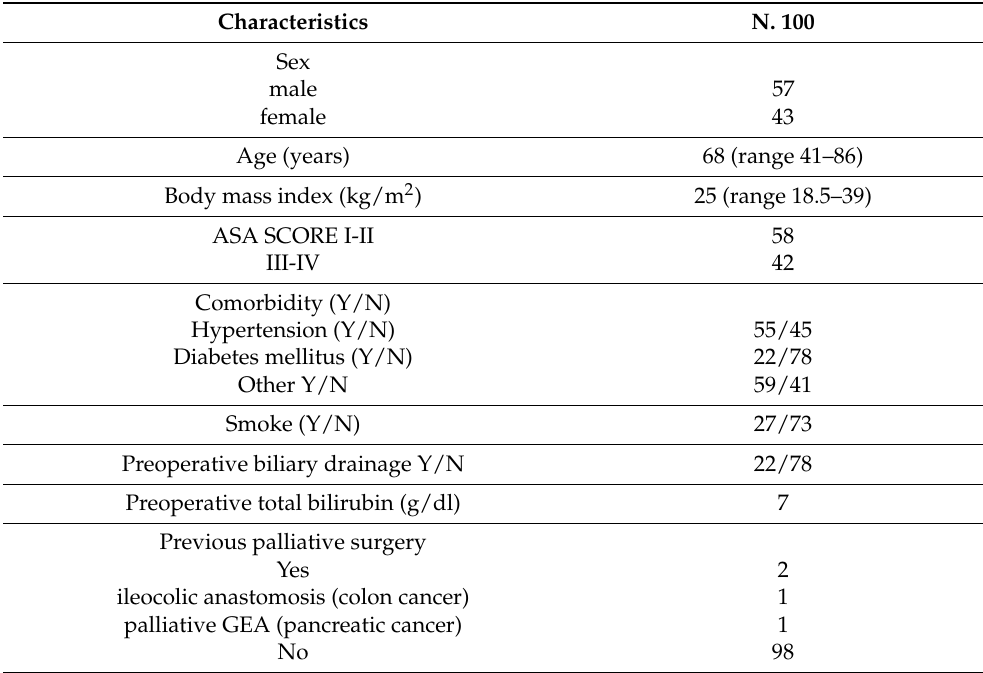
Table 1. Pre-Operative Characteristics of the patients included in the